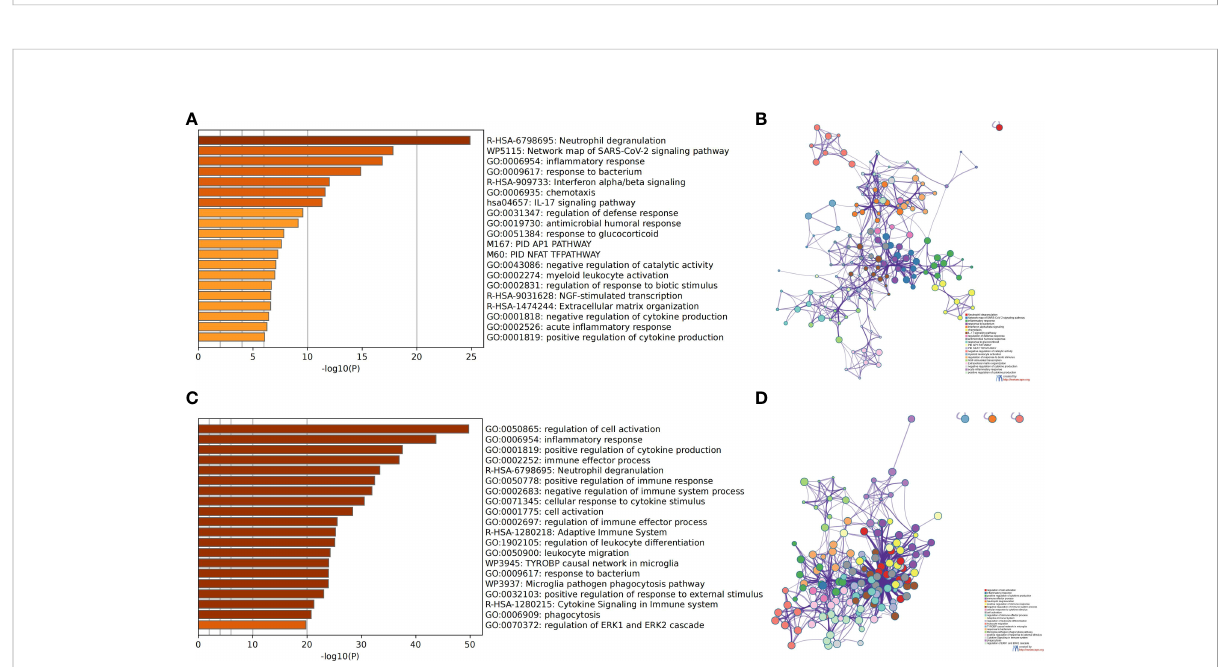
FIGURE 2 Analysis of functional characteristics of DEGs. (A) Bar chart of the DEGs in GSE50772 functional enrichment analysis. (B) Network diagram of the DEGs in GSE50772 functional enrichment analysis. (C) Bar chart of the DEGs in GSE100927 functional enrichment analysis. (D) Network diagram of the DEGs in GSE100927 functional enrichment analysis.